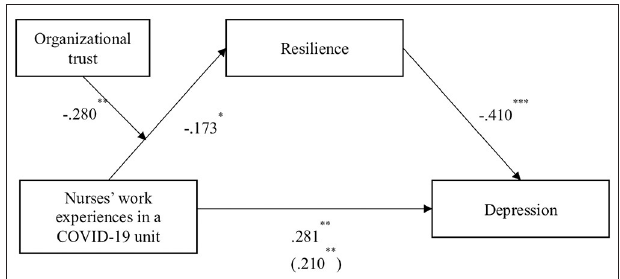
FIGURE 1 | Interaction effect of nurses’ work experiences in a COVID-19 unit and organizational trust on resilience.